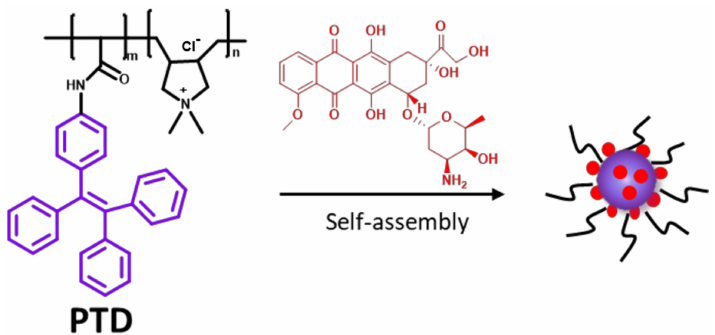
Figure 1. Schematic diagram of PTD assembly and loading DOX in aqueous.